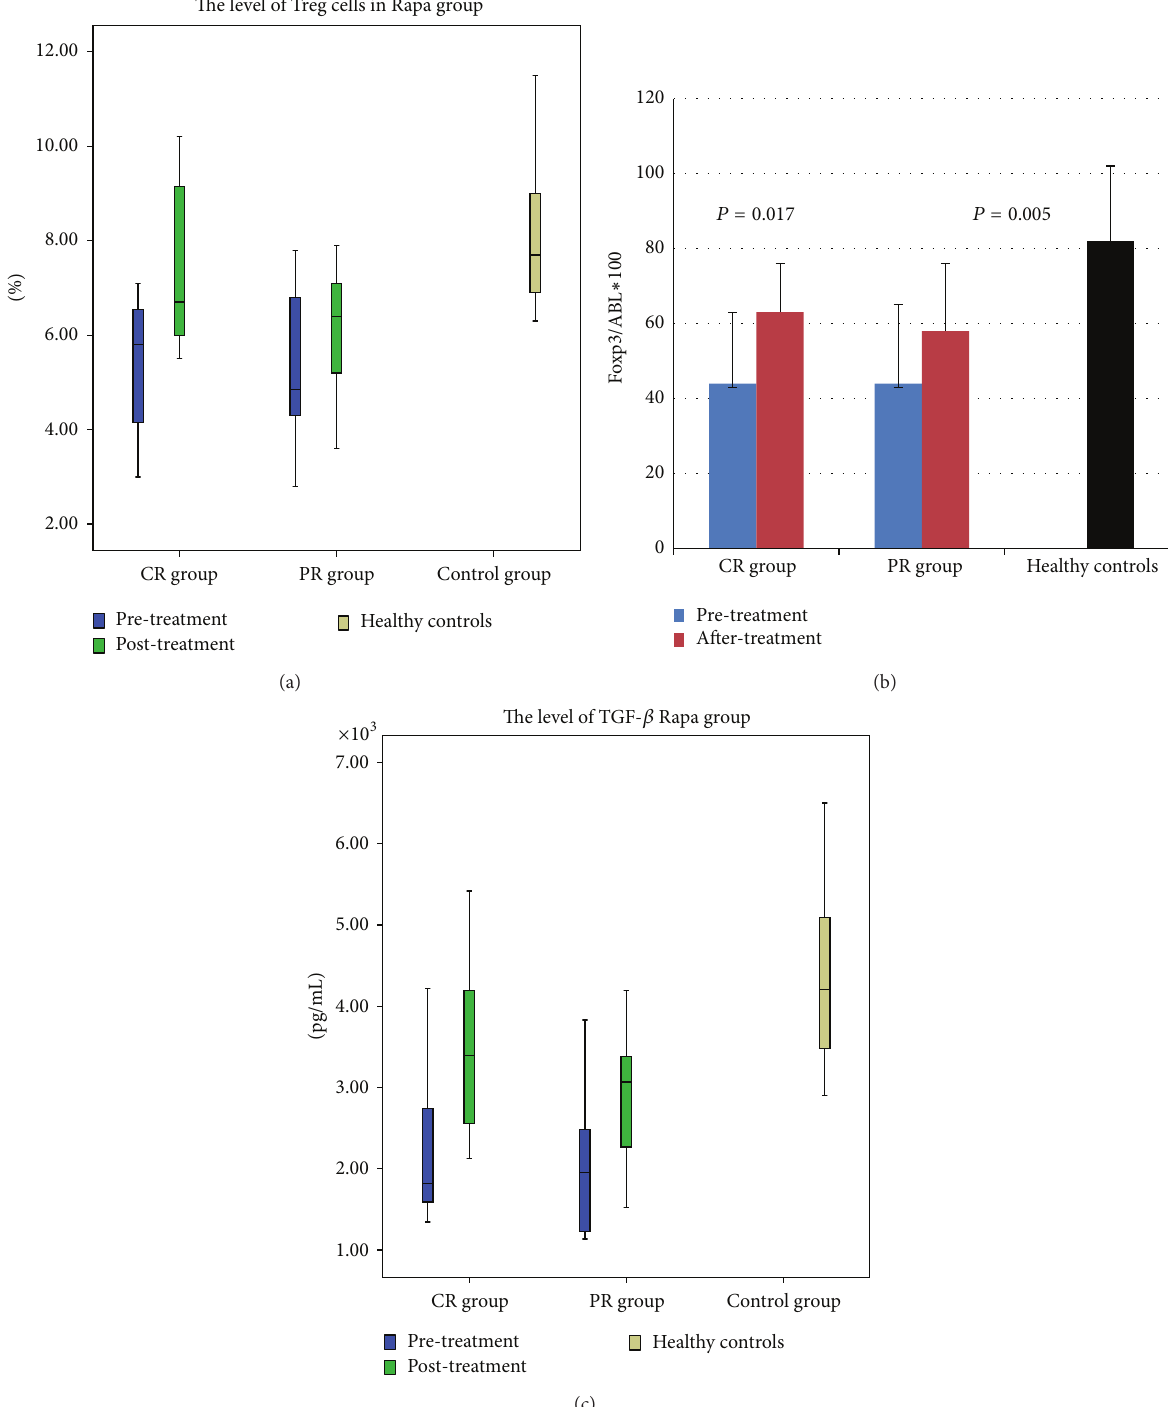
Figure 1: Immunologic assessment before and after the rapamycin or cyclosporine treatment. (a) The Treg cells levels by the flow cytometry. PatientswithCRandPRintheexperimentalgroupexperiencedamarkedupregulation(CRgroup: 5.35±1.49 %versus 7.55±1.74 %, 𝑃 = 0.013 ; PR group: 5.17 ± 1.65 % versus 6. 12 ± 1.43 %, 𝑃 = 0.015 ); (b) the expression of Foxp3 mRNA by quantitative RT-PCR assay. It was consistent with the increase in Treg cells level (CR group: 44 ± 19 versus 63 ± 13 , 𝑃 = 0.017 ; PR group: 44 ± 21 versus 58 ± 18 , 𝑃 = 0.005 ); (c) the plasma levels of TGF- 𝛽 by the enzyme-linked immunosorbent assay. A significant increase in the level of TGF- 𝛽 was observed after the rapamycin treatment (CR group: 2.38 ± 1.0 ng/mL versus 3.57 ± 1.1 ng/mL, 𝑃 = 0.028 ; PR group: 2.04 ± 0.92 ng/mL versus 2. 90 ± 0.8 ng/mL, 𝑃 = 0.001